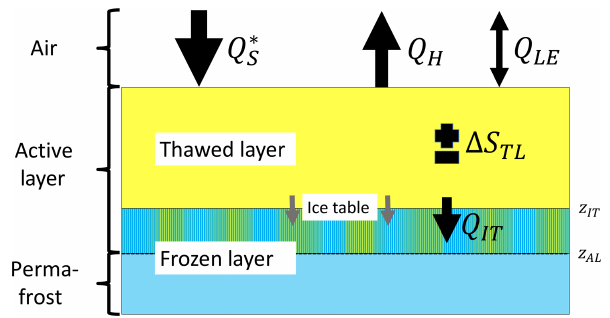
Figure 1. Surface energy balance concept used in this study, with net radiation Q ∗ , sensible heat flux Q H , latent evaporative heat S flux Q LE , temporal storage change in the thawed layer (cid:49)S TL , and soil heat flux at ice table depth Q IT . Ground heat flux is given by adding together (cid:49)S TL and Q IT . Black arrows depict observed di- rections of energy fluxes. The soil profile can be divided by the ac- tive layer depth z AL into the seasonally thawed active layer and the perennially frozen permafrost, or by the ice table depth z IT into the currently thawed and frozen layers, where the ice table equals the thawing front advancing into the soil, denoted by grey